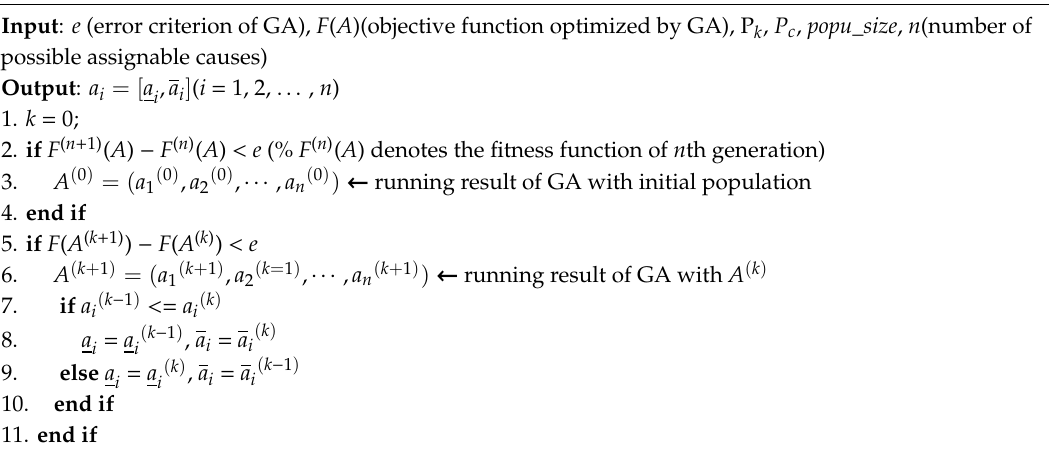
Algorithm 1 : < Solving fuzzy relational equation by GA